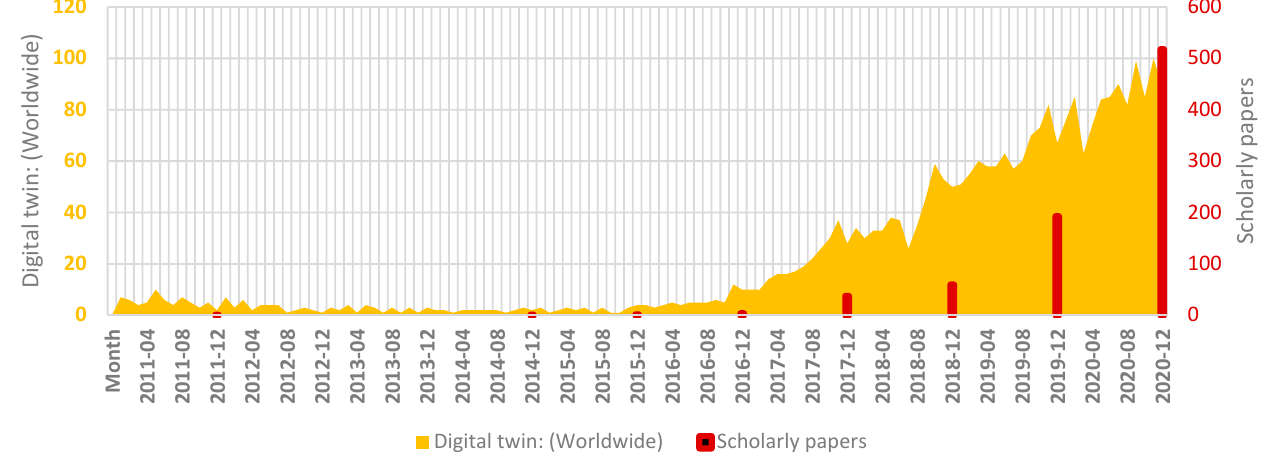
Figure 2. Trend analysis showing an exponential rise in search for the DT topic.